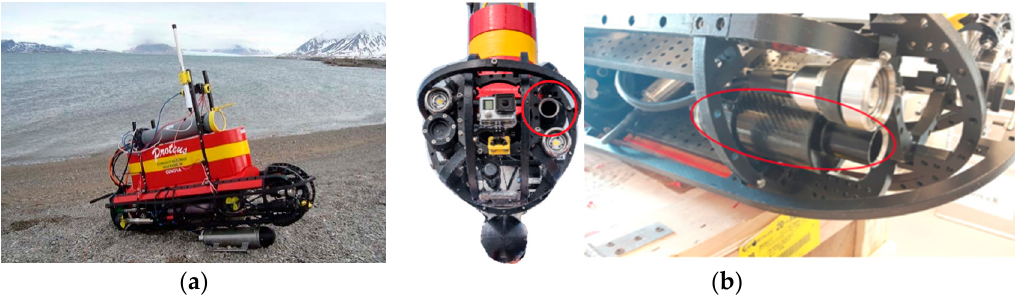
Figure 5. ( a ) PROTEUS vehicle; ( b ) front and side view of PROTEUS (circle shows ArLoC installed on board).